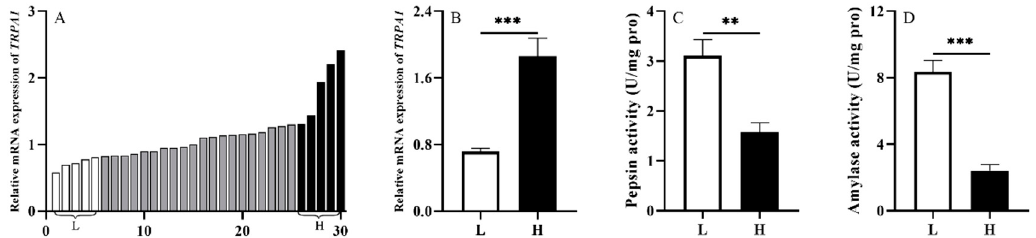
Figure 3. TRPA1 is involved in food digestion of Strongylocentrotus intermedius . ( A ) The expression of TRPA1 in the gut of S. intermedius ( n = 30). ( B ) TRPA1 expression of groups L and H ( n = 5). ( C , D ) The activities of pepsin and amylase in the gut of the groups L and H ( n = 5). The symbols ** and *** mean p < 0.01 and p < 0.001, respectively (mean ± s.e.m.).